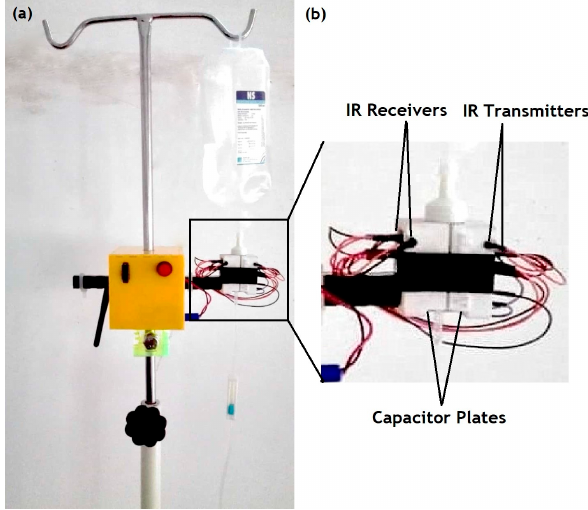
Figure 3. ( a ) The device in a hospital setting and ( b ) various sensors in the sensing unit.